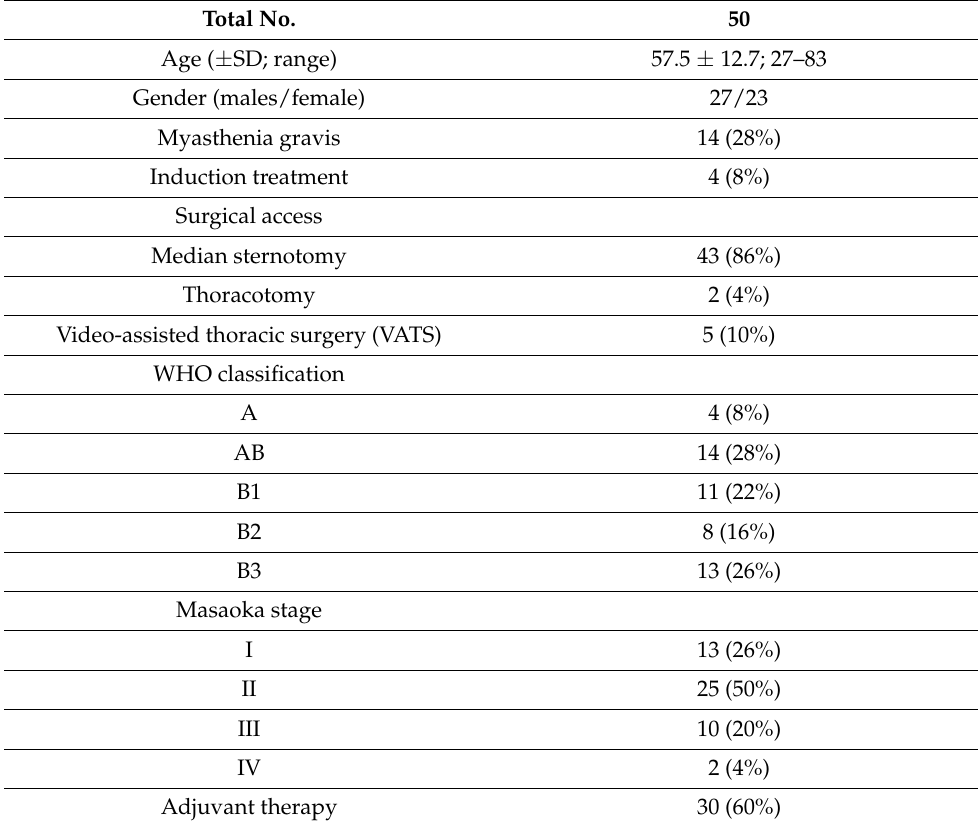
Table 1. Patients’ characteristics.